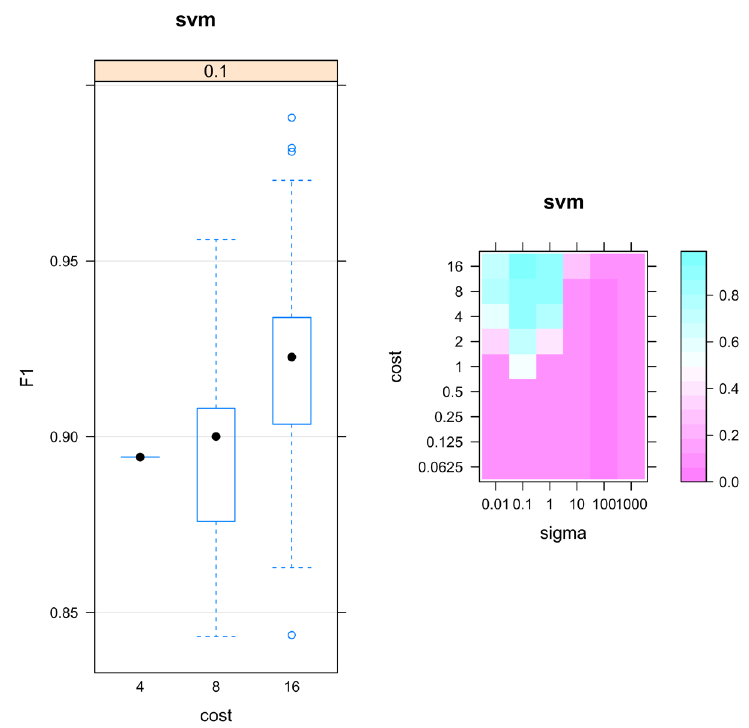
Figure 15. Assessment of the classification model parameter